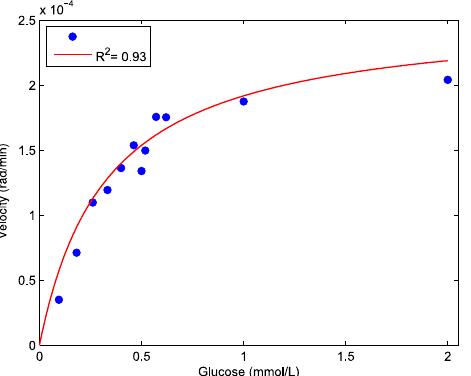
Figure 2. Hexokinase substrate saturation curve: Initial reaction velocity (rad/min) plotted against initial glucose concentrations (mM). Red line shows non-linear regression ( R 2 = 0.93) to the parameters in Equation 3 from which K M is obtained.